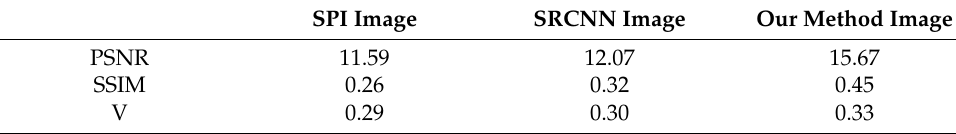
Table 4. The respective PSNR and SSIM for different methods (the letter “G”).